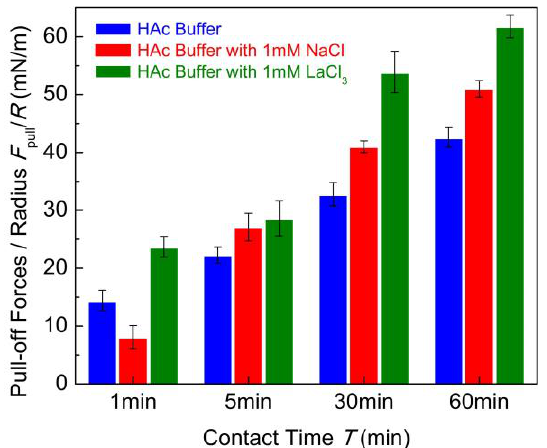
Figure 4. Pull-o ff forces F pull / R between two chitosan films in 100 mM HAc bu ff er in the presence of Figure 4. Pull-off forces F pull /R between two chitosan films in 100 mM HAc buffer in the presence of salt-free, 1 mM LaCl 3 and 1 mM NaCl with di ff erent contact salt-free, 1 mM LaCl 3 and 1 mM NaCl with different contact times.